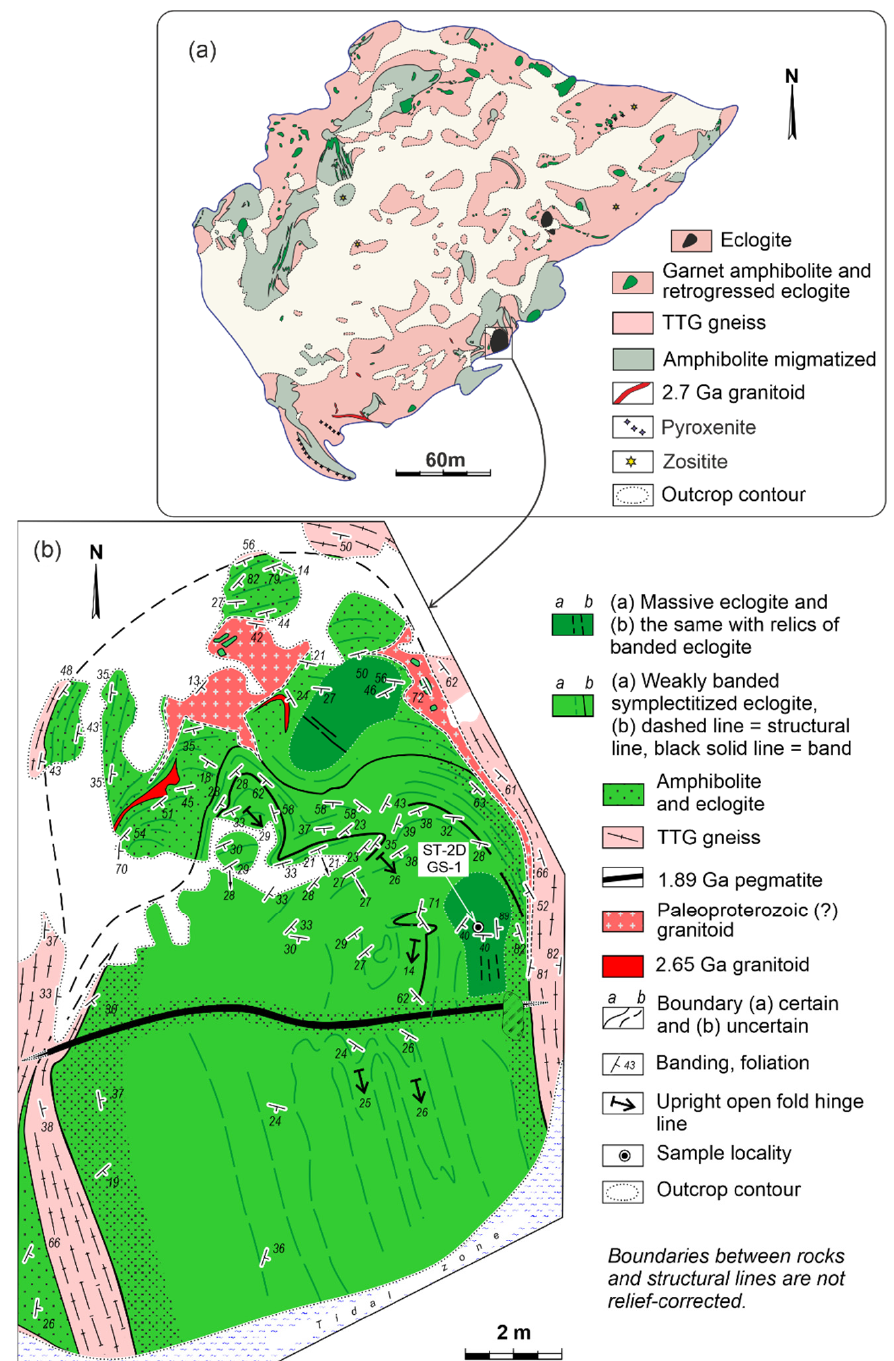
Figure 2. Geological maps of ( a ) Stolbikha Island and ( b ) an amphibolite boudin containing relics of eclogites (modified from [27]); samples from the massive eclogites: ST-2D (this study) and GS-1 [57].